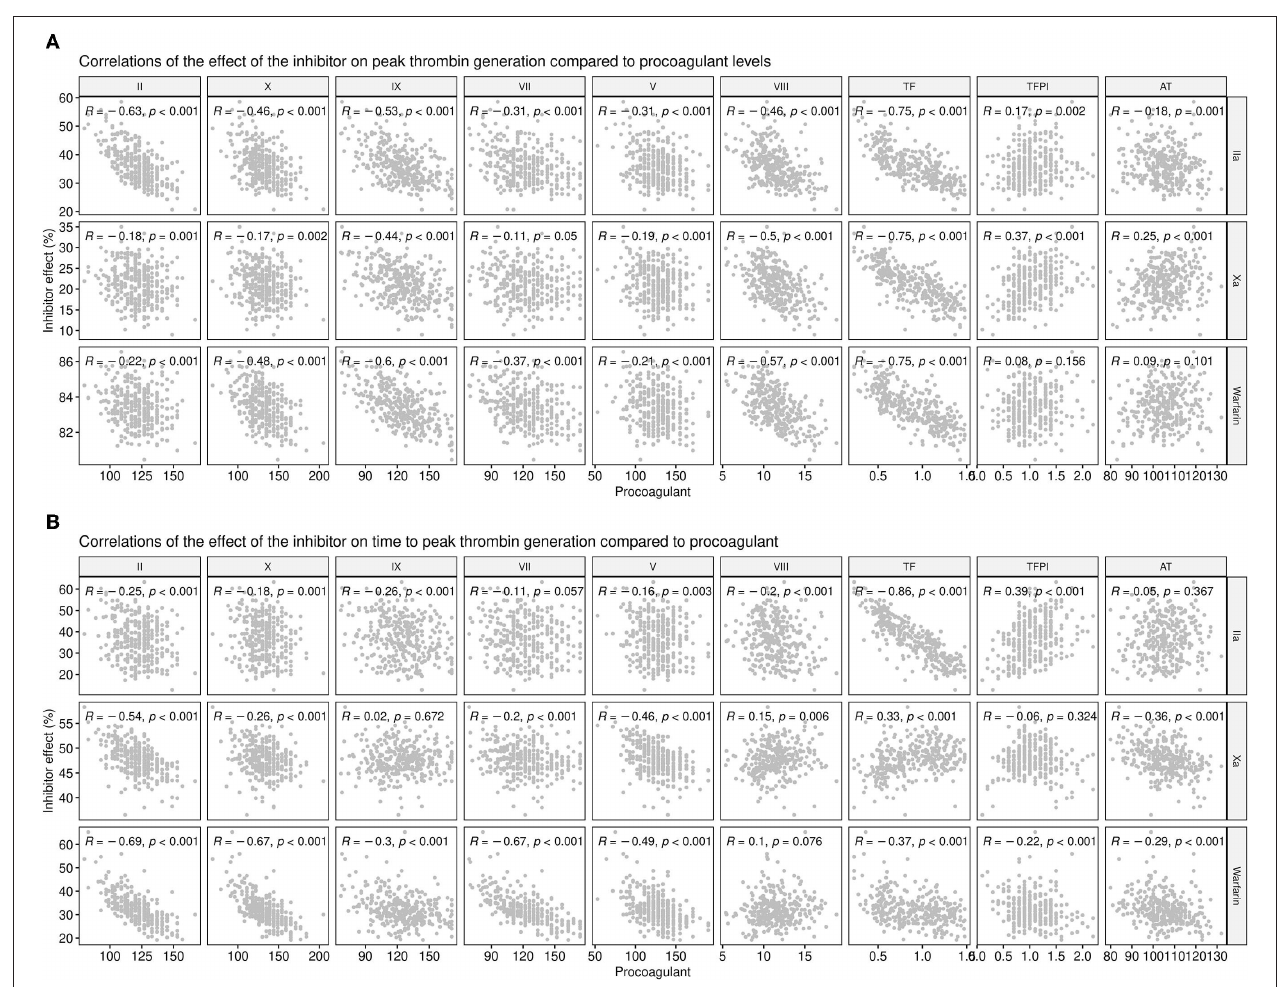
FIGURE 8 | Correlations between procoagulant levels and the predicted effect of anticoagulant drugs at the standard therapeutic dose. Correlations between the measured levels of each coagulation factor (x-axes) or inhibitor with the predicted thrombin generation in the presence of anticoagulant drugs (y-axes) show the effect on (A) Peak thrombin and (B) time to reach peak thrombin. The predicted effects of the direct thrombin inhibitor, dabigatran (IIA), the FXa inhibitor, and warfarin, at standard therapeutic doses are shown as a